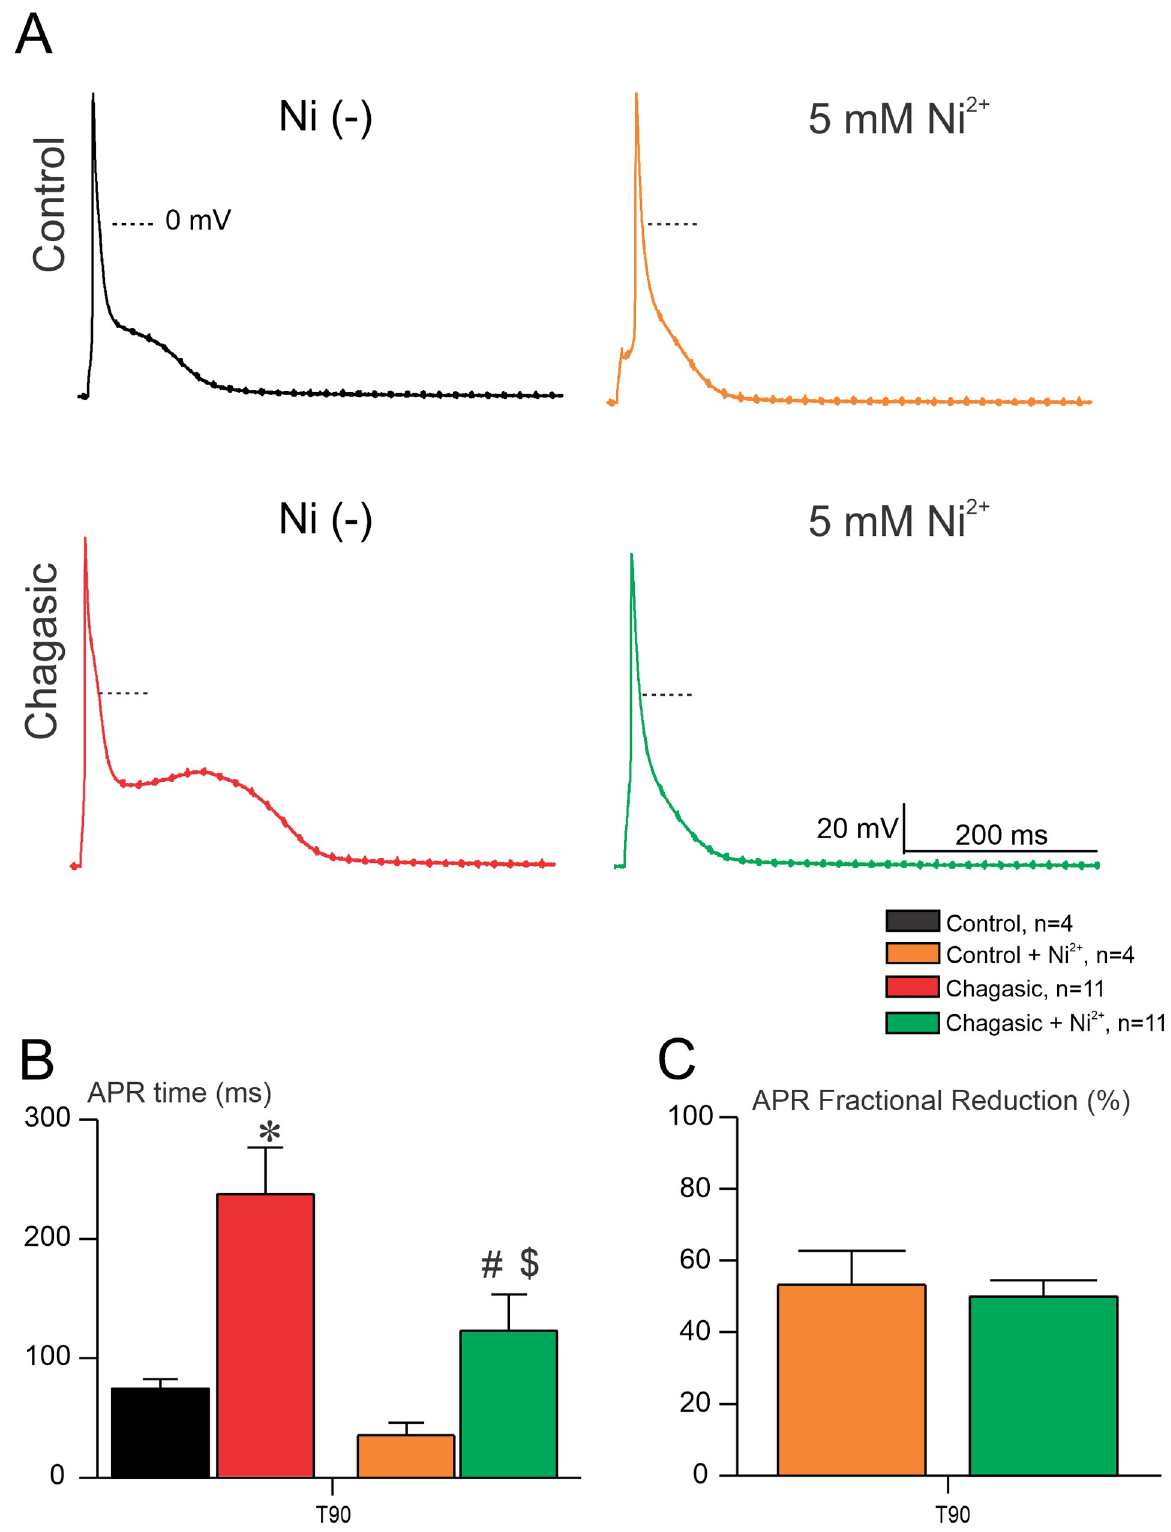
Fig 3. Ni 2+ shortens action potential duration in chronic phase of experimental Chagas disease. (A) Representative AP recorded from isolated cardiomyocytes from control and infected mice, before and after perfusion of Ni 2+ (5 mM). (B) Time required to reach 90% (T 90 ) of full AP repolarization before and after exposure to Ni 2+ (5 mM). (C) AP repolarization (APR) fractional reduction taken at 90% after challenge control and chagasic cardiomyocytes with Ni 2+ at 5mM. Data were compared using one-way ANOVA (B) and Student’s t test (C). n represents the number of cells. � comparing Chagasic to control prior Ni 2+ , # comparing Chagasic prior and after Ni 2+ , $ comparing Chagasic to control after Ni 2+ (p < 0.05).